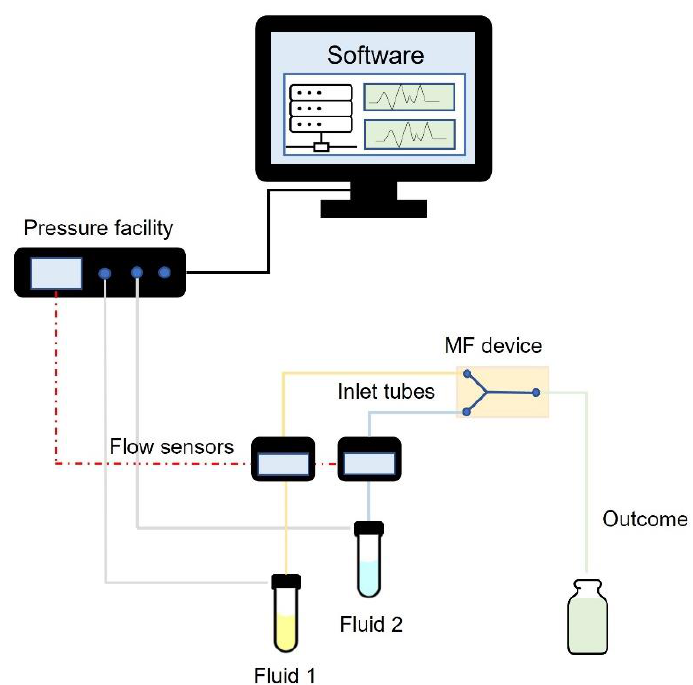
Figure 2. Schematic representation of MF-based setup.